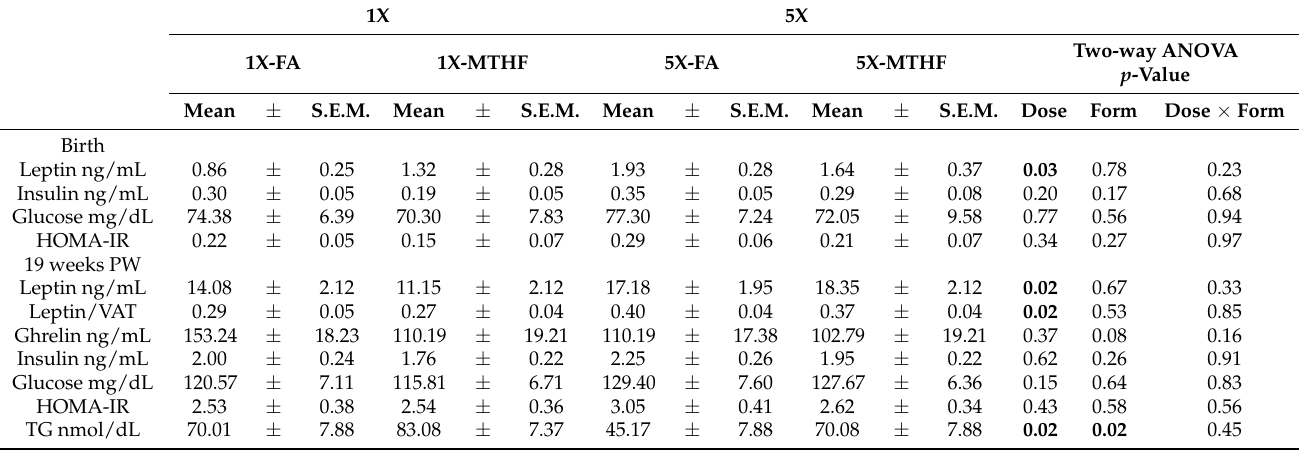
Table 2. Plasma metabolic measures in female offspring at birth and 19 weeks